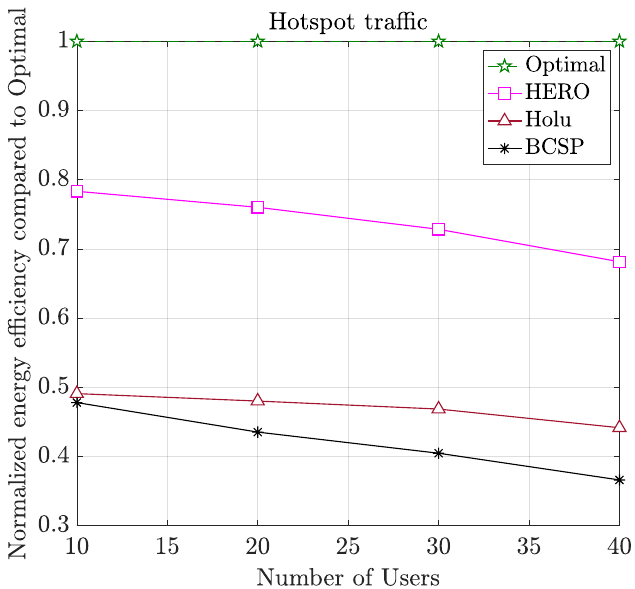
Figure 6. Energy efficiency (bits/Joule) of all algorithms for different numbers of UEs per gNB area.